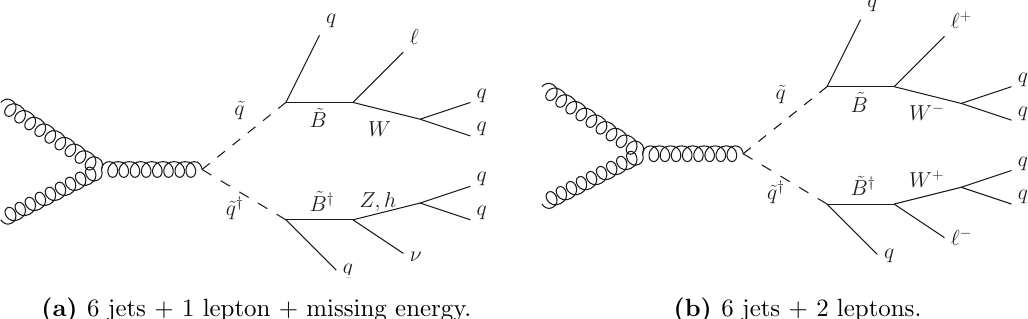
Figure 3. Final states with leptons and missing energy. Leptoquark searches are recast for these